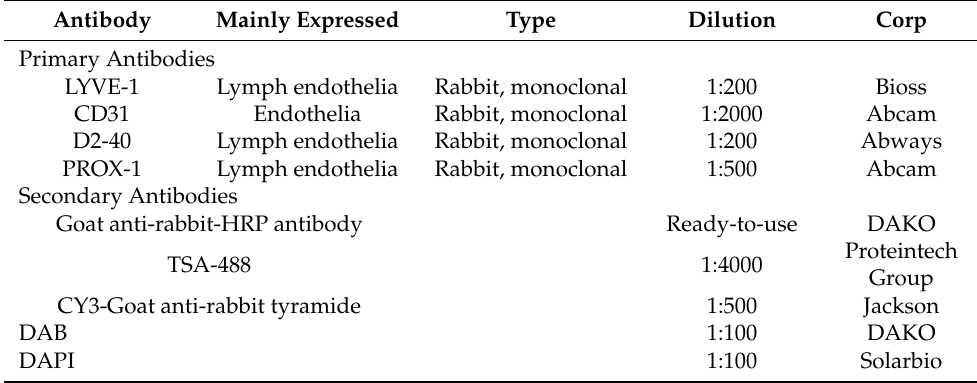
Table A1. Antibodies used for immunohistochemistry and immunofluorescent